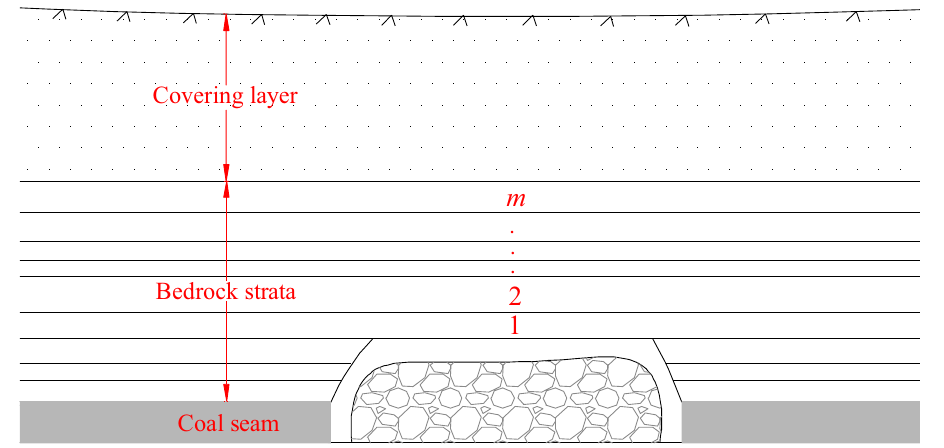
Figure 1. Distribution of overlying strata in shallow thick coal